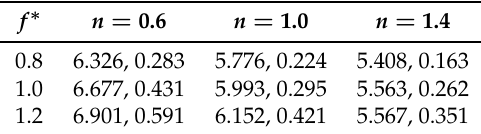
Table 6. Time-averaged Nusselt number ( Nu ) and its amplitude ( ∆ Nu ) for forced convection heat transfer from an oscillating cylinder to power-law fluids at Re = 100, Pr = 1.0, and H ∗ = 1.0. f ∗ n = 0.6 n =